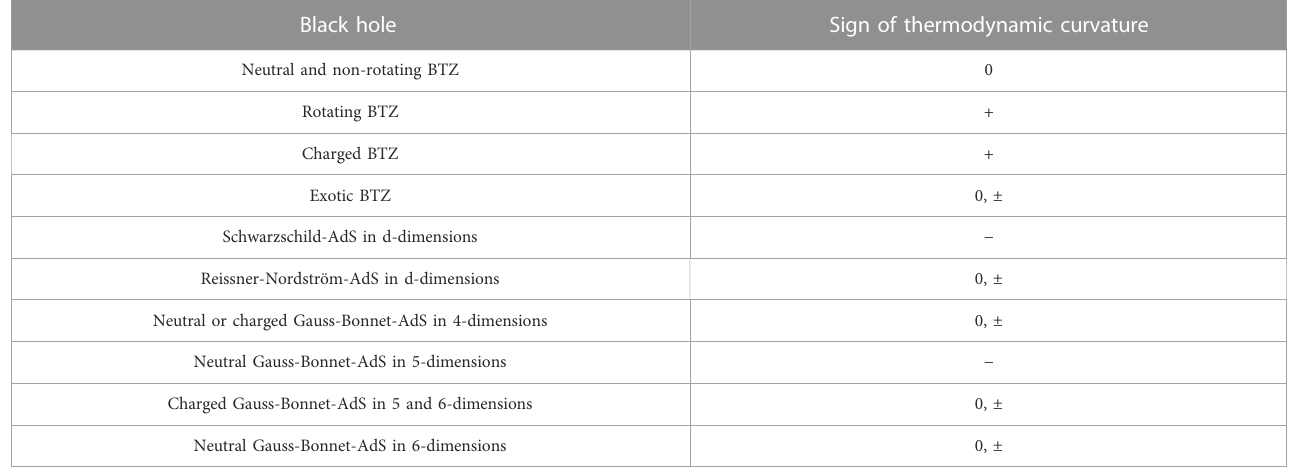
TABLE2SignofRuppeiner curvatureforsomeblackholesinAdS[27,28,37 – 42,44 – 49,51 – 55,57 – 72].Inthe tablebelow, by “ neutral ” wemeanthe absenceofelectric charge. Black hole Sign of thermodynamic curvature Neutral and non-rotating BTZ 0 Rotating BTZ